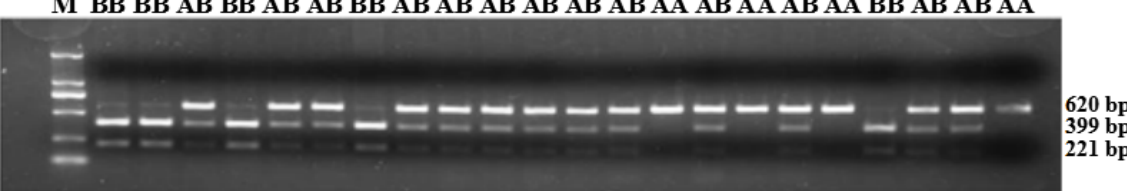
Figure 5. PCR-restriction fragment length polymorphism results for the ZNF33B gene in Changbaishan black cattle. Genotype AA repre- sents allele gene GG, and genotype BB represents allele gene TT, AB for GT or TG. Genotype AA has single band with a length of 620bp, and BB has double bands (399 and 221bp); AB has three bands (top to bottom: 620, 399, and 221bp).